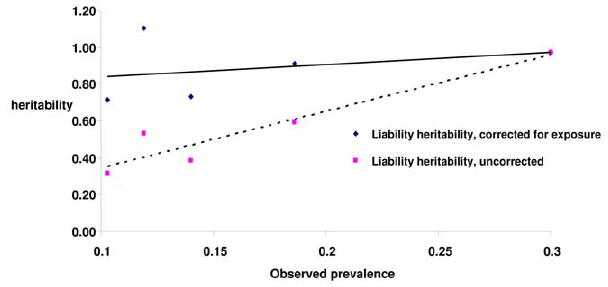
Figure 5. Heritabilities for liability to death from infectious pancreatic necrosis in five cohorts of Atlantic salmon, before and after correction for inferred relative exposure levels. The data are from Guy et al. 2009 [19]. Shown are heritability values and linear regression trend lines.